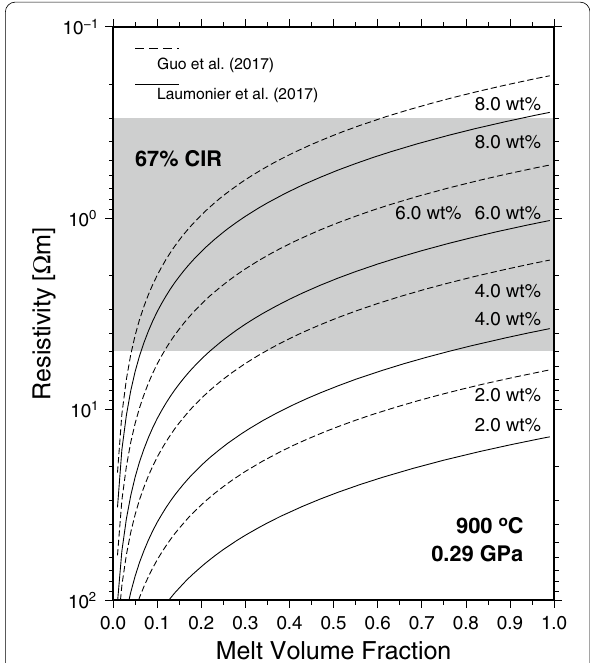
Fig. 20 Bulk resistivity (solid line) of andesitic melt and rock complex at 900 °C, 0.29 GPa as a function of melt volume fraction and of water content in the andesitic melt. Melt resistivity calculations from Guo et al. (2017) are shown by the broken line, and from Laumonier et al. (2017) are shown by the solid line. Solid phase resistivity is fixed at 500 Ωm [e.g., rhyolite data of Kariya and Shankland (1983)]. Others are the same as Fig. 19